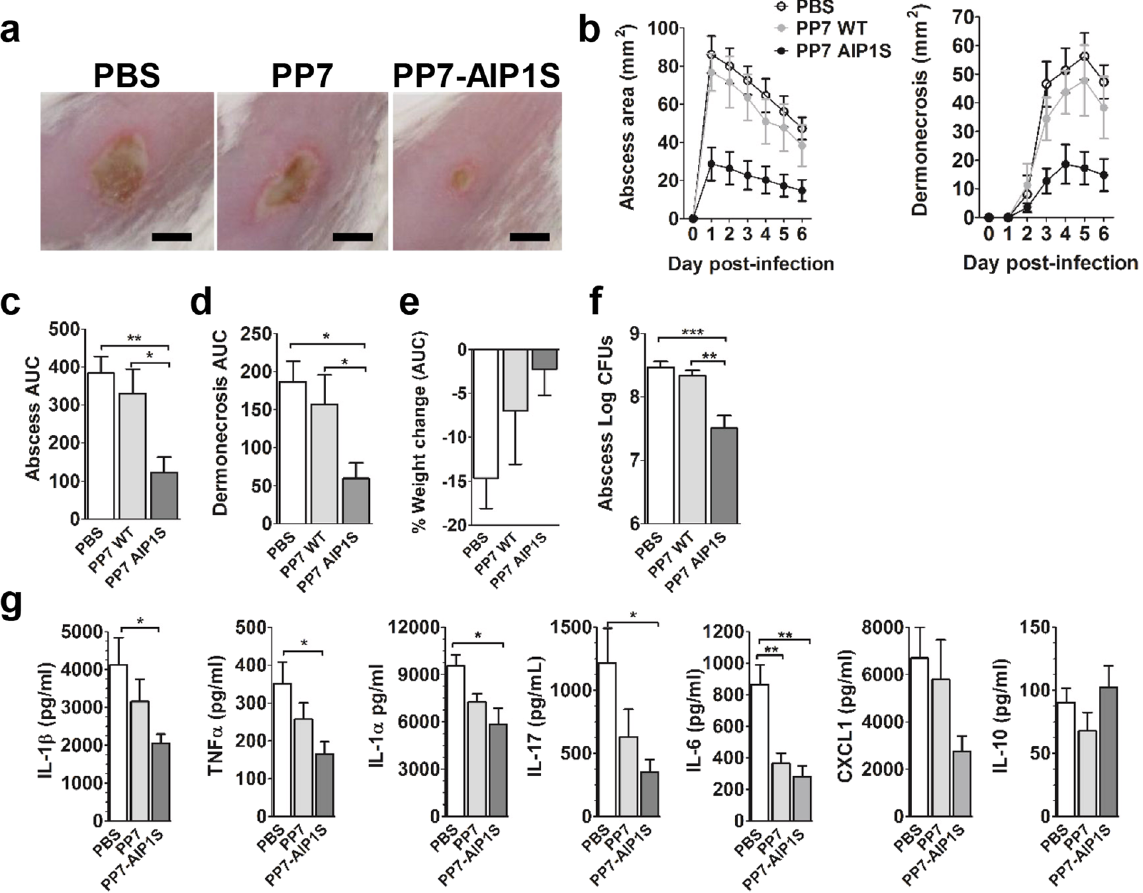
Figure 3. PP7-AIP1S vaccination limits the severity of S. aureus skin infection in a mouse model of dermonecrosis. BALB/c mice were vaccinated twice (i.m.) at 4 week intervals with 10 µ g of the indicated VLPs or PBS control. Eight weeks after the second vaccination, mice were challenged by subcutaneous infection with 4 × 10 7 CFU of USA300 LAC. Representative ( a ) day 3 images of infection site and ( b ) daily measures of abscess area and dermonecrosis. Calculated area under the curve (AUC) values for ( c ) abscess area (ANOVA p < 0.0042), ( d ) dermonecrosis (p = 0.0177) and ( e ) percent weight change over the six day infection, as well as ( f ) day 6 bacterial burden at the site of infection (p = 0.0001) (representative of two independent experiments of n = 6 mice per group). ( g ) Cytokine levels in clarified abscess tissue homogenate on day 6 post-infection (ANOVA IL-1 β , p = 0.0587; TNF α , p = 0.0358; IL-1 α , p = 0.0171; IL-17, p = 0.0322; IL-6, p = 0.0010) (n = 6 mice per group). Data are mean ± s.e.m. Newman-Keuls post test: ns, not significant; * p < 0.05; ** p < 0.01; *** p <